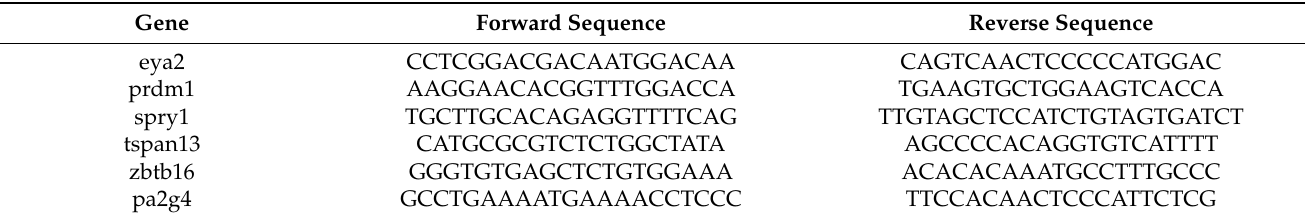
Table 1. qPCR primer sequences.